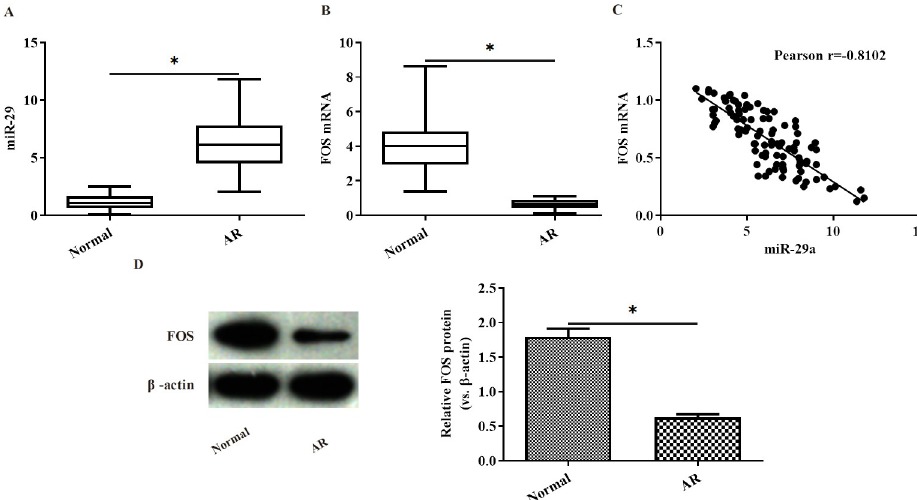
Fig 1. The expression of miR-29a and FOS mRNA in the nasal tissues from AR patients and healthy controls. (A-B) The expression of miR-29a and FOS mRNA in the nasal tissues from AR patients and healthy controls was analyzed by PCR; (C) the correlation in the expression between miR-29a and FOS mRNA was analyzed by Pearson correlation analysis; (D) FOS protein expression in the nasal tissues from AR patients and healthy controls was analyzed by western Blot. � p <